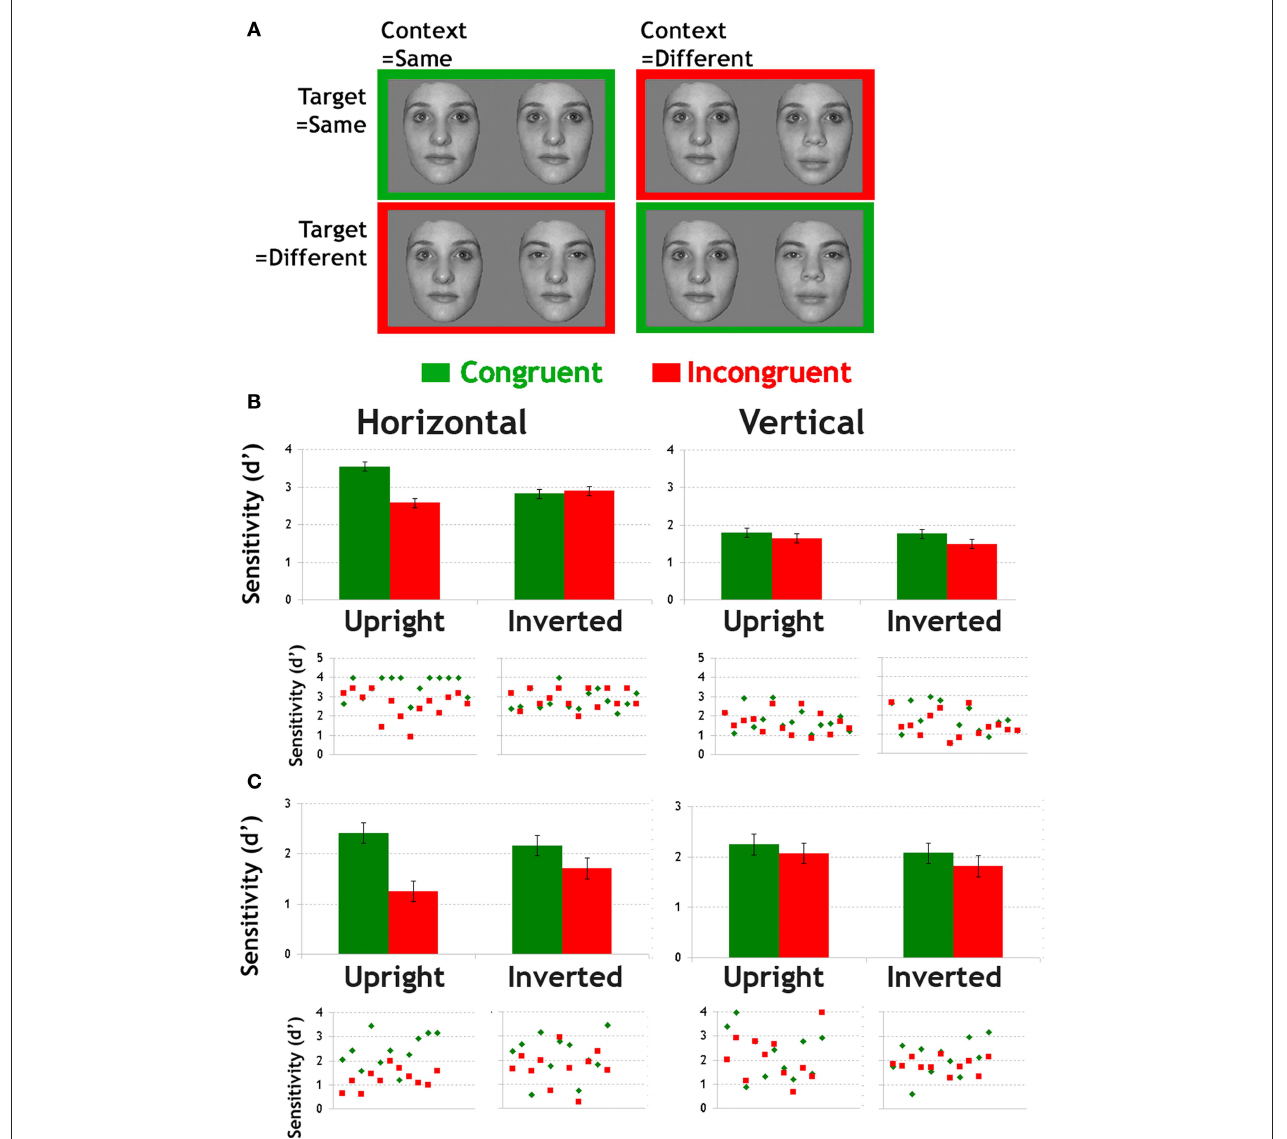
bars represent MSE. The bottom scatter plots illustrate individual data for congruent and incongruent trials in each filter- and planar-orientation condition. (C) Results of the follow-up experiment. Horizontally filtered stimuli were combined with white noise and presented shortly in order to equate sensitivity levels in upright-congruent conditions. Top graphs show mean sensitivity and the bottom scatter plots show individual data. Error